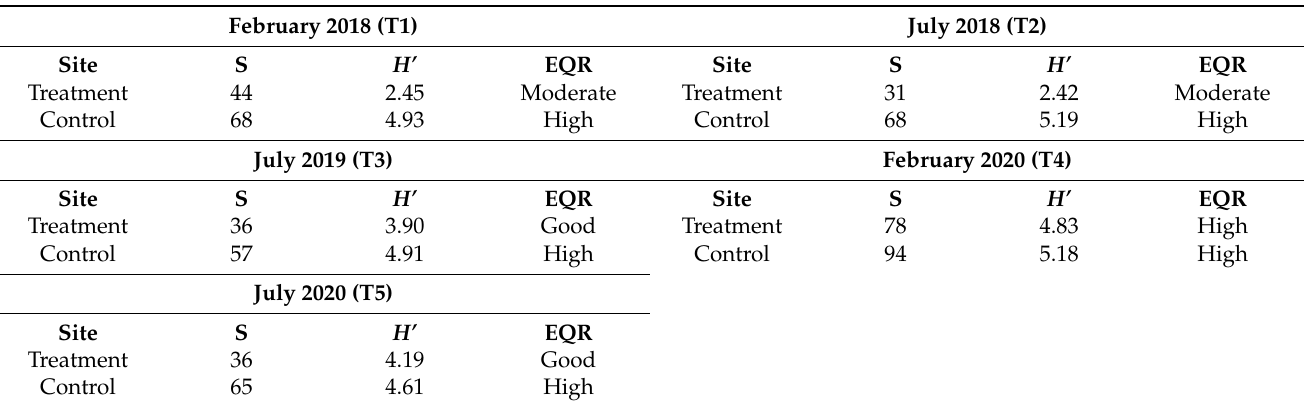
Table 2. Richness (S), diversity ( H’ ) and Ecological Quality Ratio (EQR) of the two sampling sites over